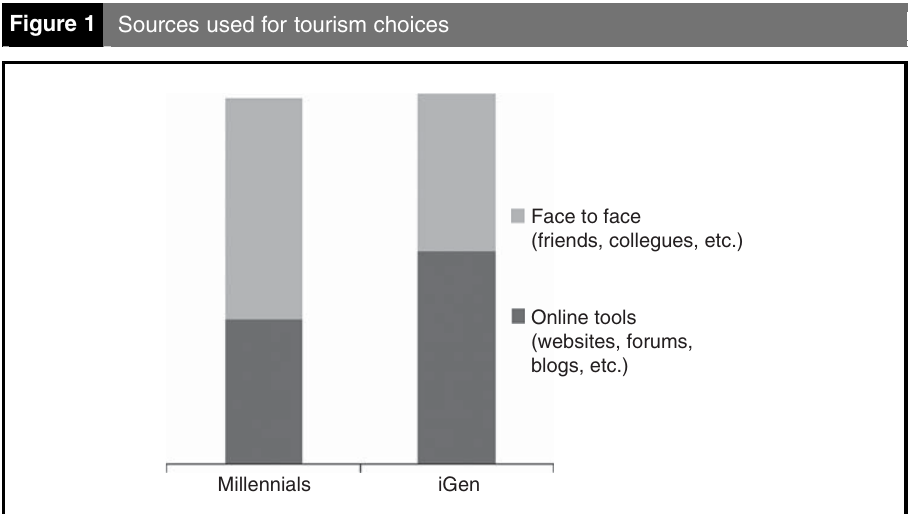
Millennials iGen